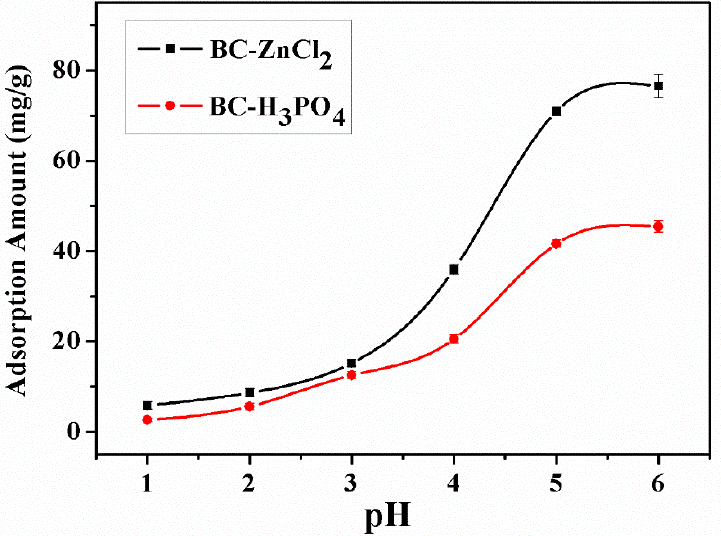
Figure 5. Adsorption amount of Pb 2+ with various pHs.